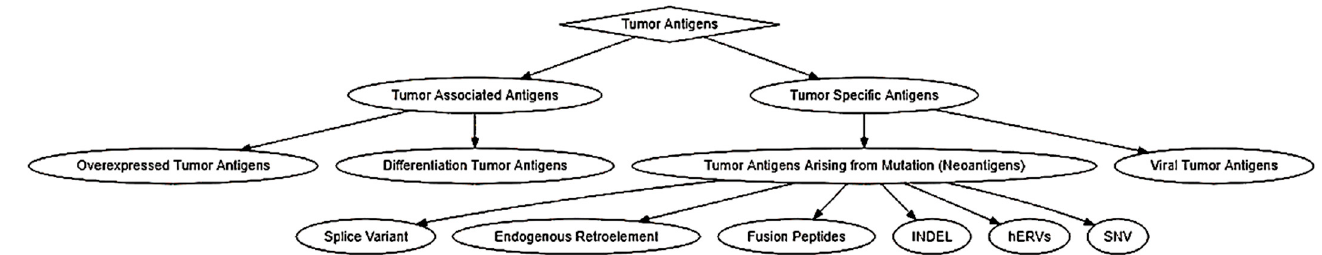
Figure 1. Tumor antigen classifications.